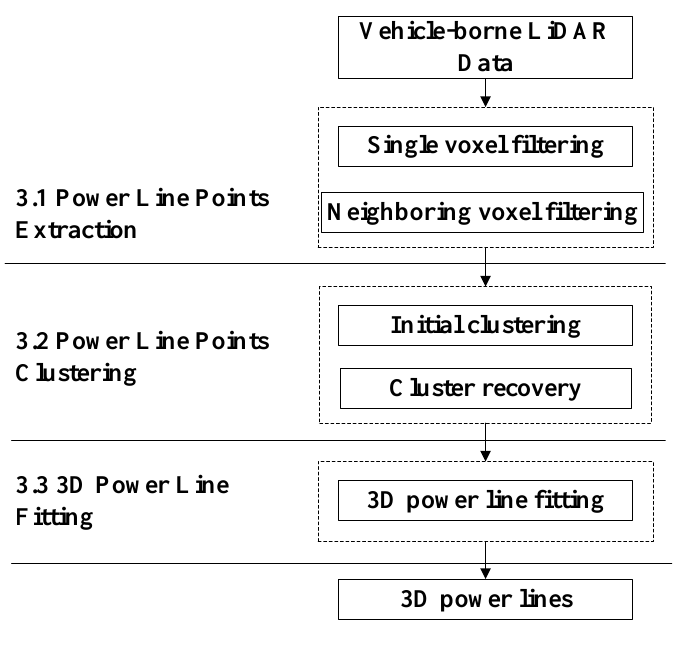
Figure 3. Flow of the power line extraction procedure based on vehicle-borne LiDAR